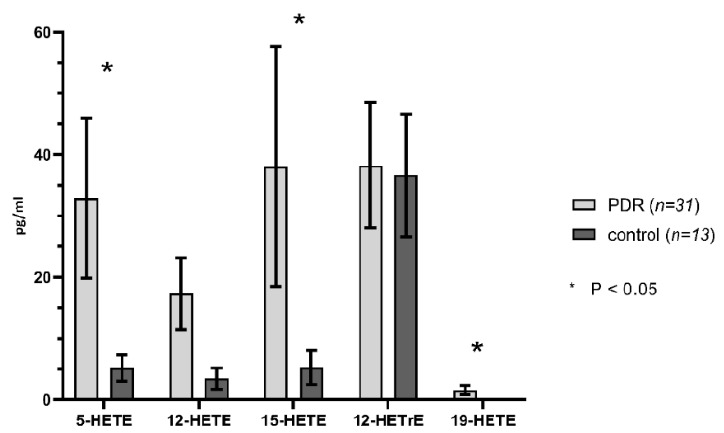
Figure 2. Human vitreous levels of eicosanoids in PDR ( n = 31) vs. control ( n = 13) eyes. Comparison of levels (pg / mL) of 5-HETE, 12-HETE, 15-HETE, 12-HETrE, and 19-HETE in PDR vs. controls. * denotes statistical significance ( p < 0.05).